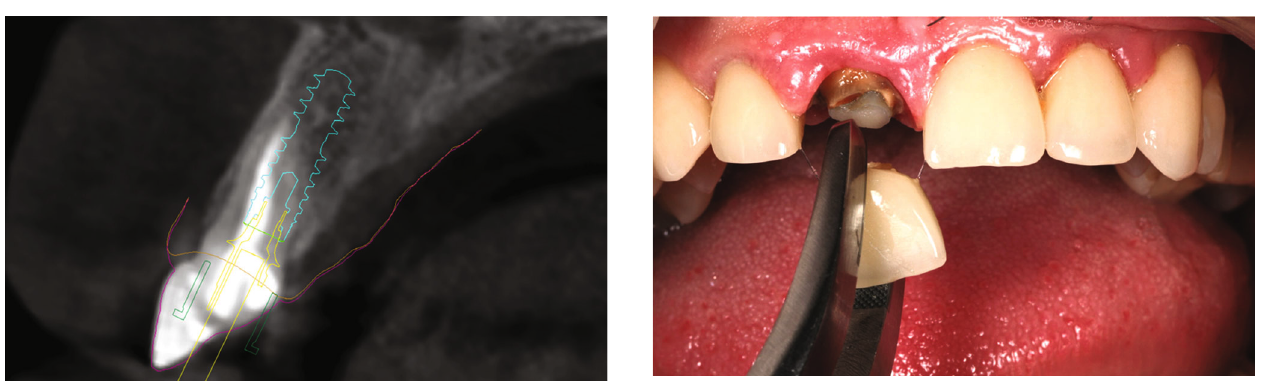
Figure 2: The planning phases overlapped: intraoral starting point — .STL scan of starting position — tooth #11 virtual extraction.